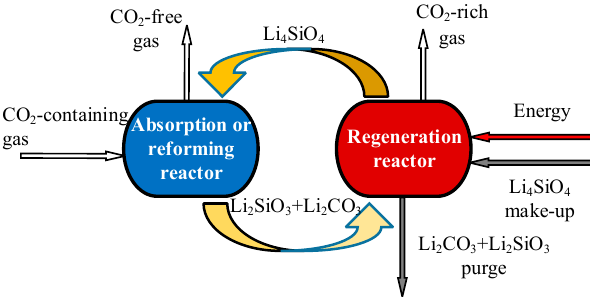
Figure 1. Application of Li 4 SiO 4 material for CO 2 absorption for fossil fuel-fired power plants or hydrogen plants based on sorption-enhanced reforming.